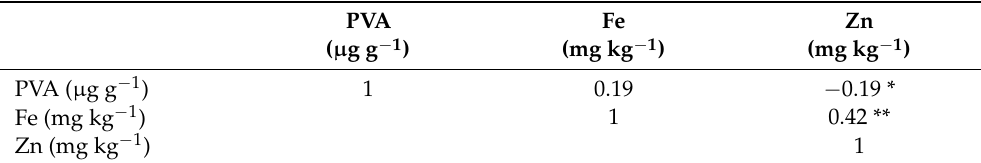
Table 7. Pearson correlation coefficients among Fe, Zn and PVA contents in hybrids evaluated across environments.